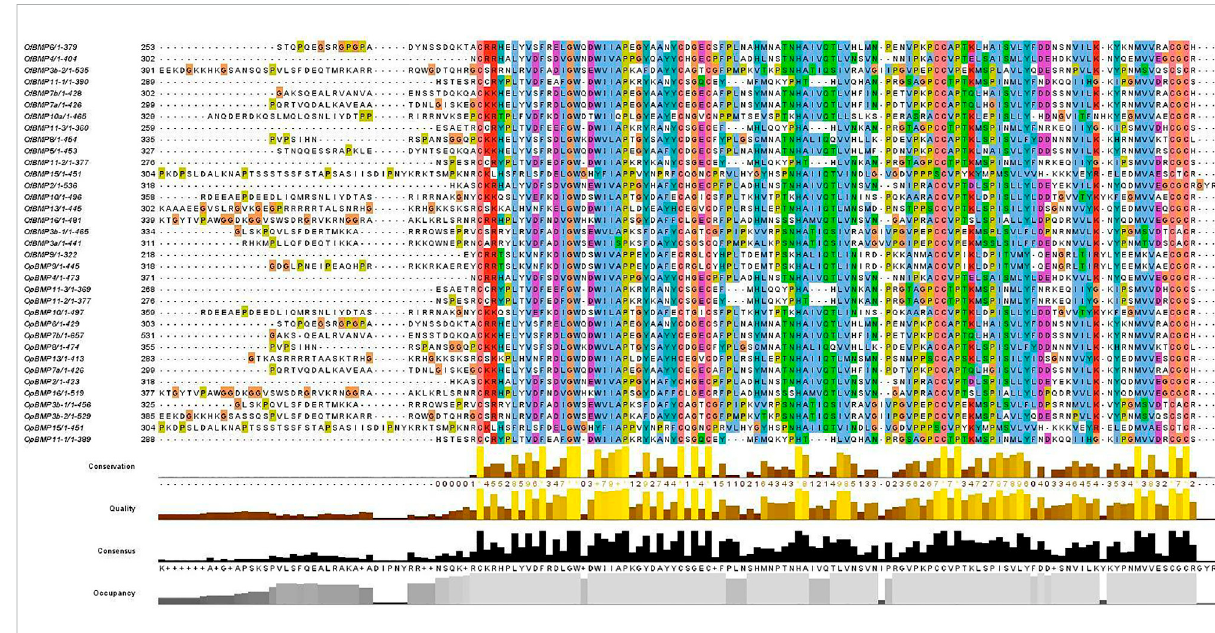
FIGURE 3 Multiple sequence alignment of the conserved domains of proteins in the Oplegnathus BMP gene